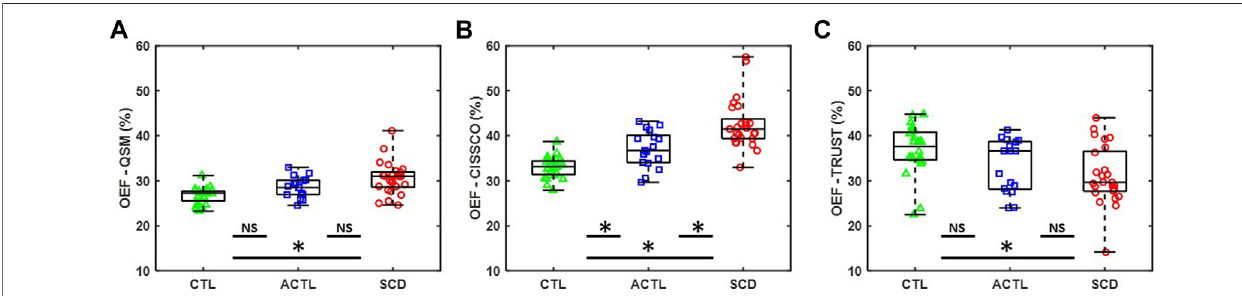
FIGURE 2 | Group differences for OEF measurements by CISSCO, QSM and TRUST. (A) Boxplot for OEF-QSM in internal cerebral vein for SCD, ACTL and CTL. (B) Boxplot for OEF-CISSCO in internal cerebral vein for SCD, ACTL and CTL. (C) Boxplot for OEF-TRUST in sagittal sinus for SCD, ACTL and CTL. (* denoted